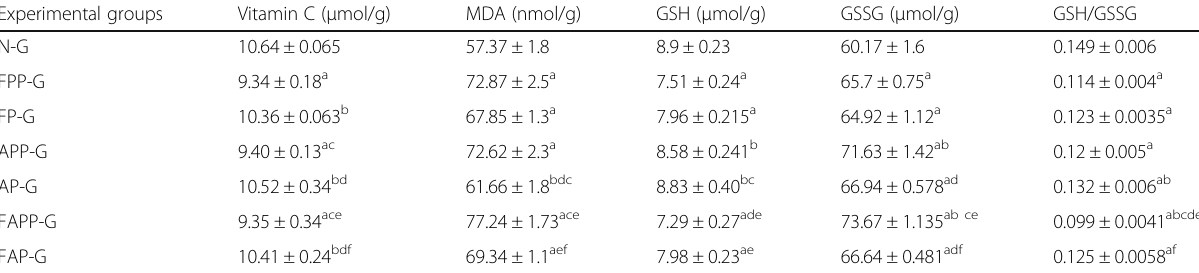
Table 3 The levels of vitamin C, malondialdehyde (MDA), glutathione (GSH), and glutathione disulphide (GSSG) and the ratio of GSH to GSSG in the liver of offspring rats exposed to NaF or AlCl 3 alone and in combination through the pre- or/and postnatal stages until 70 days